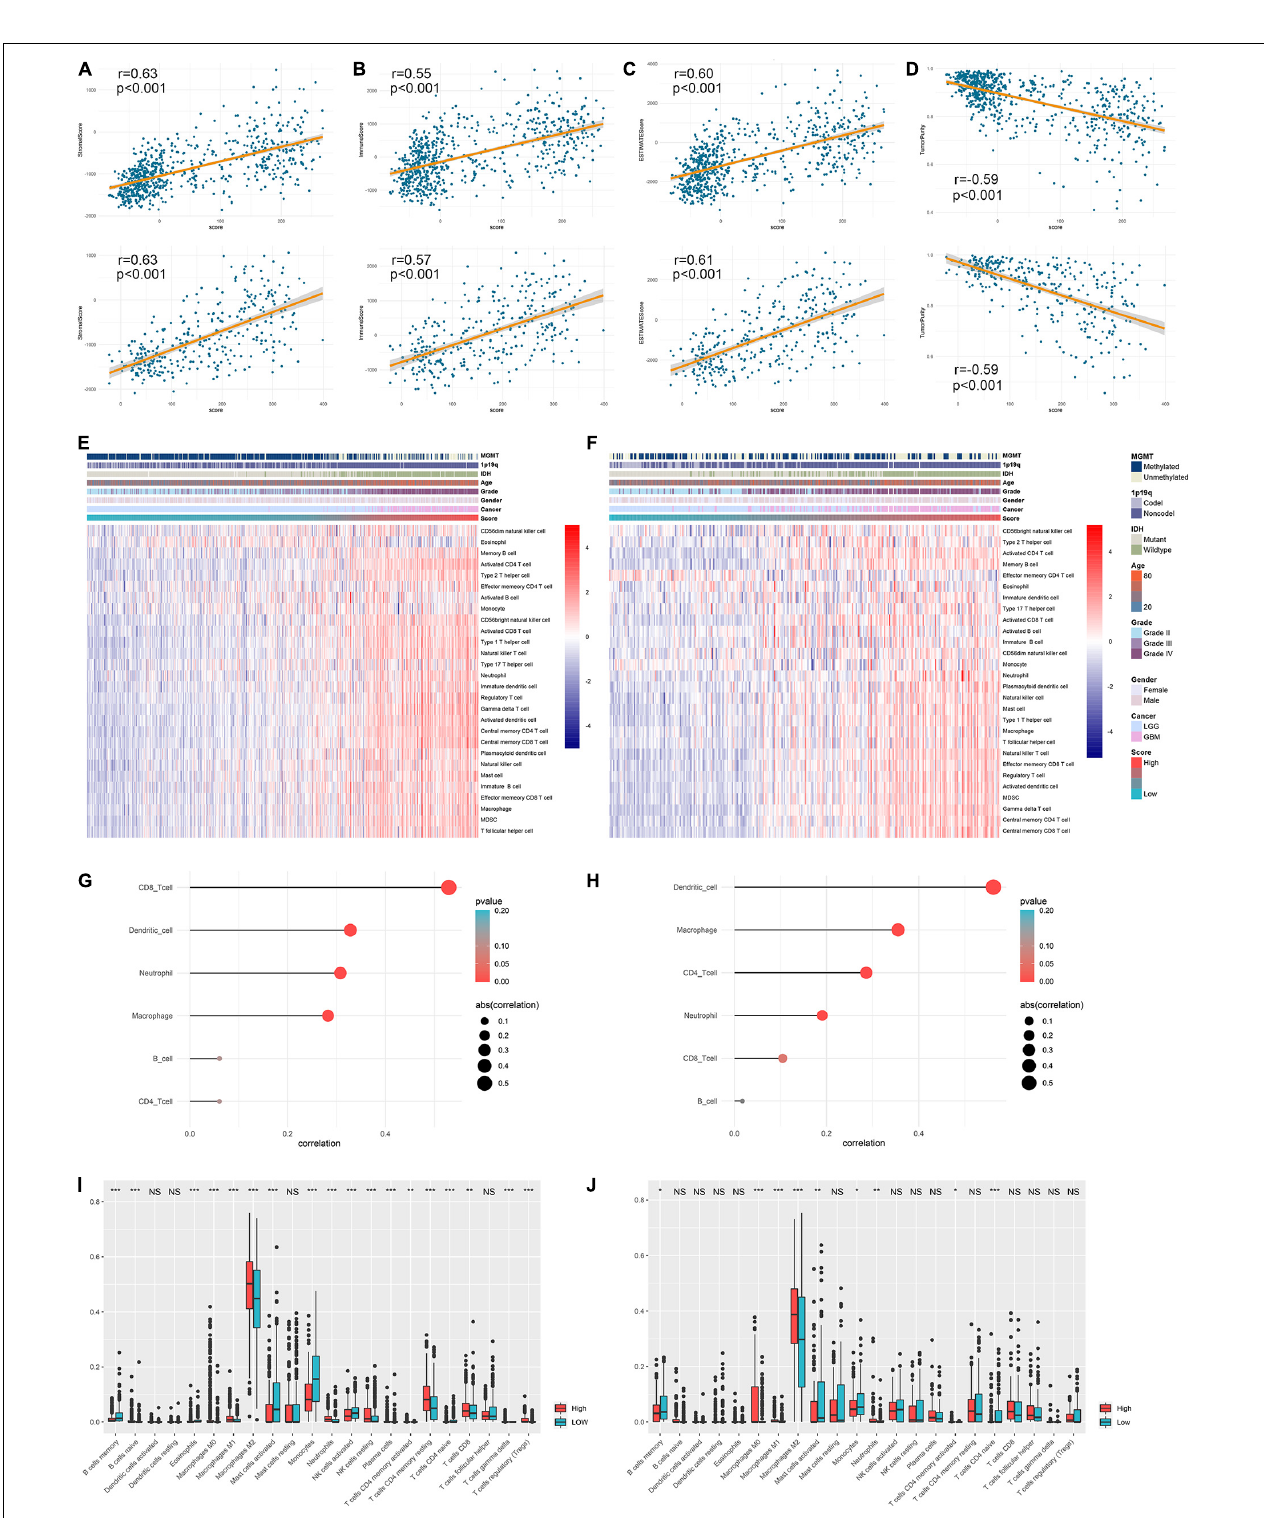
FIGURE 7 | ARL score was associated with immune infiltration in diffuse gliomas. (A–D) Correlation between ARL score with stromal score (A) , immune score (B) , ESTIMATE score (C) , and tumor purity (D) in TCGA and CGGA datasets. (E,F) The infiltration of different immune cells revealed by ssGSEA algorithm in low-score and high-score patients in TCGA (E) and CGGA (F) datasets. (G,H) The correlation between ARL score with the abundance of six immune cells estimated by TIMER algorithm in TCGA (G) and CGGA (H) datasets. (I,J) CIBERSORT algorithm revealed the abundance of different immune cells in low-score and high-score groups in TCGA (I) and CGGA (J) datasets. ∗ p < 0.05; ∗∗ p < 0.01; ∗∗∗ p < 0.001.